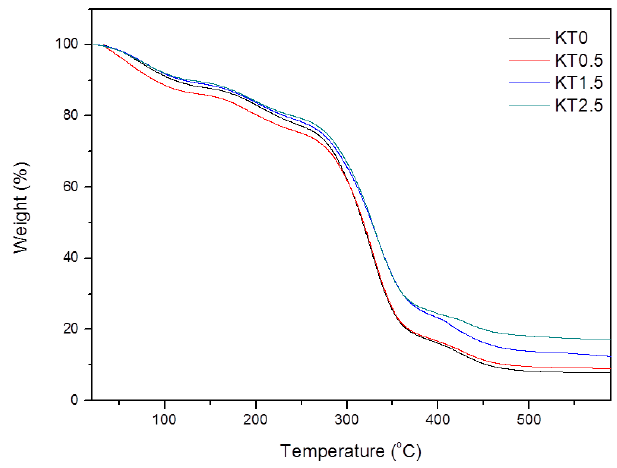
Figure 7. TGA of the composite films (KT0.5~KT2.5).